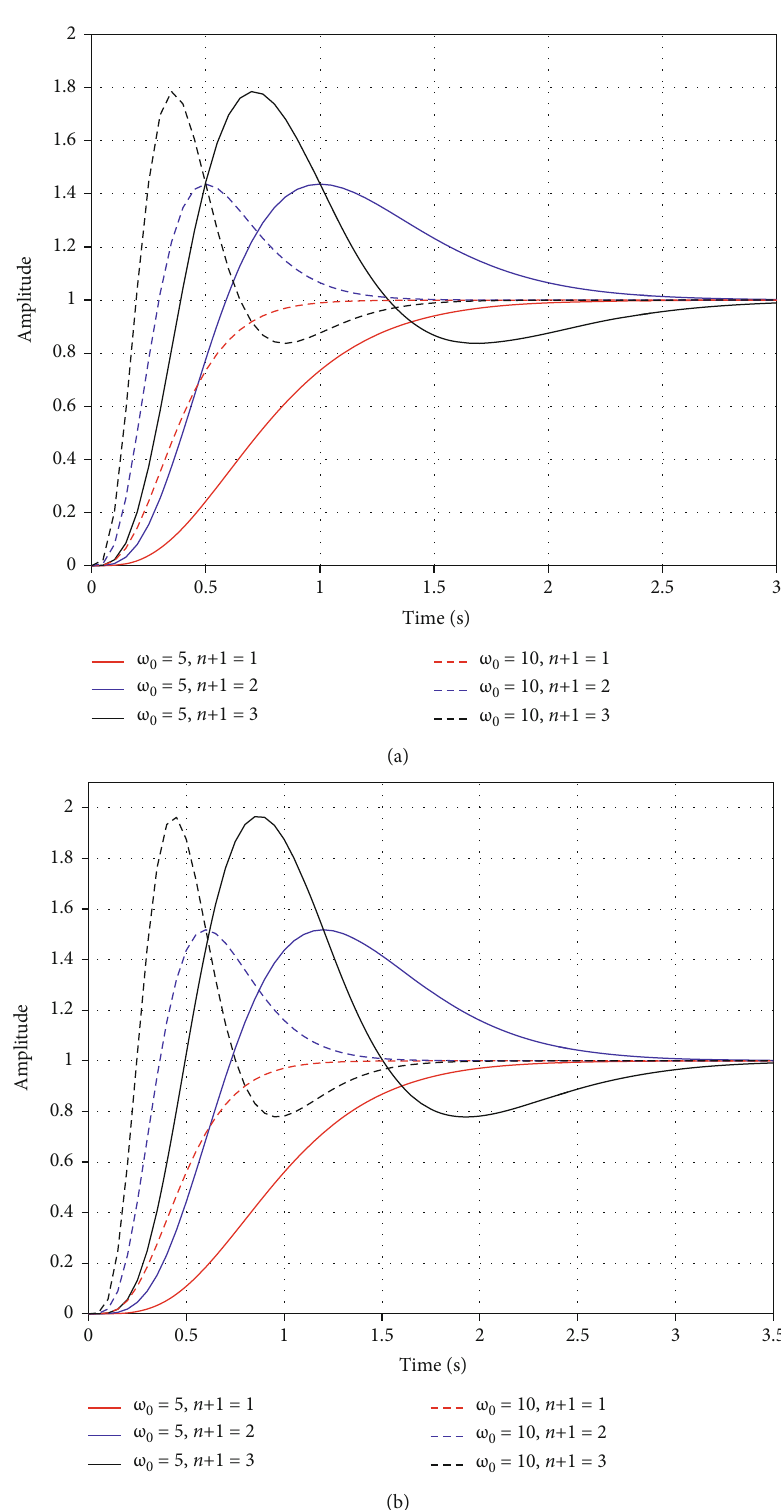
Figure 1: Step response of high-order LESO disturbance estimates: (a) system order is 3; (b) system order is